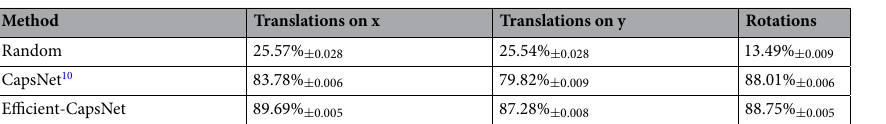
Table 5. Average percentage of variance captured by the first component of PCA performed on the output capsule vectors of the different transformations applied to test set images.